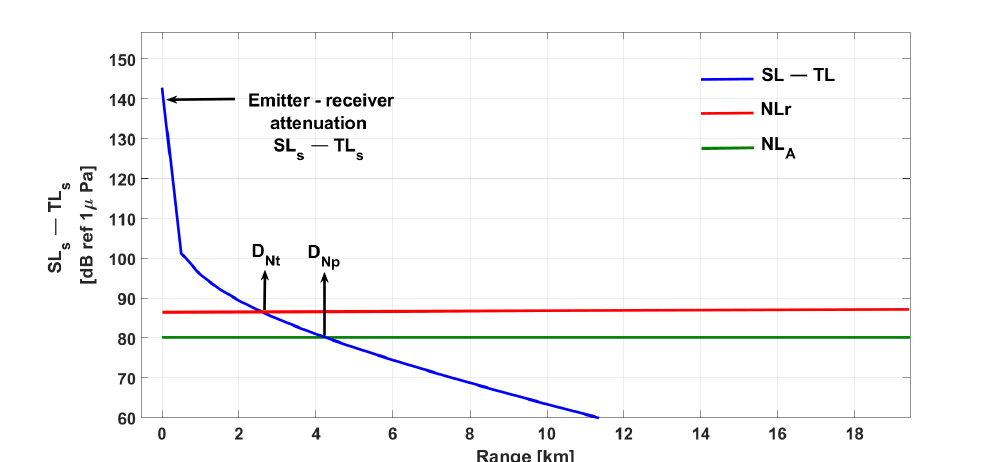
Figure 7. The intersection between the decay curve of the sound level between emitter–receiver and the noise level present in the marine area determines the maximum distance in which SNR = 0. The distances calculated considering the natural ambient noise and natural plus anthropogenic noise will determine the reduction of the communication distance due to marine traffic